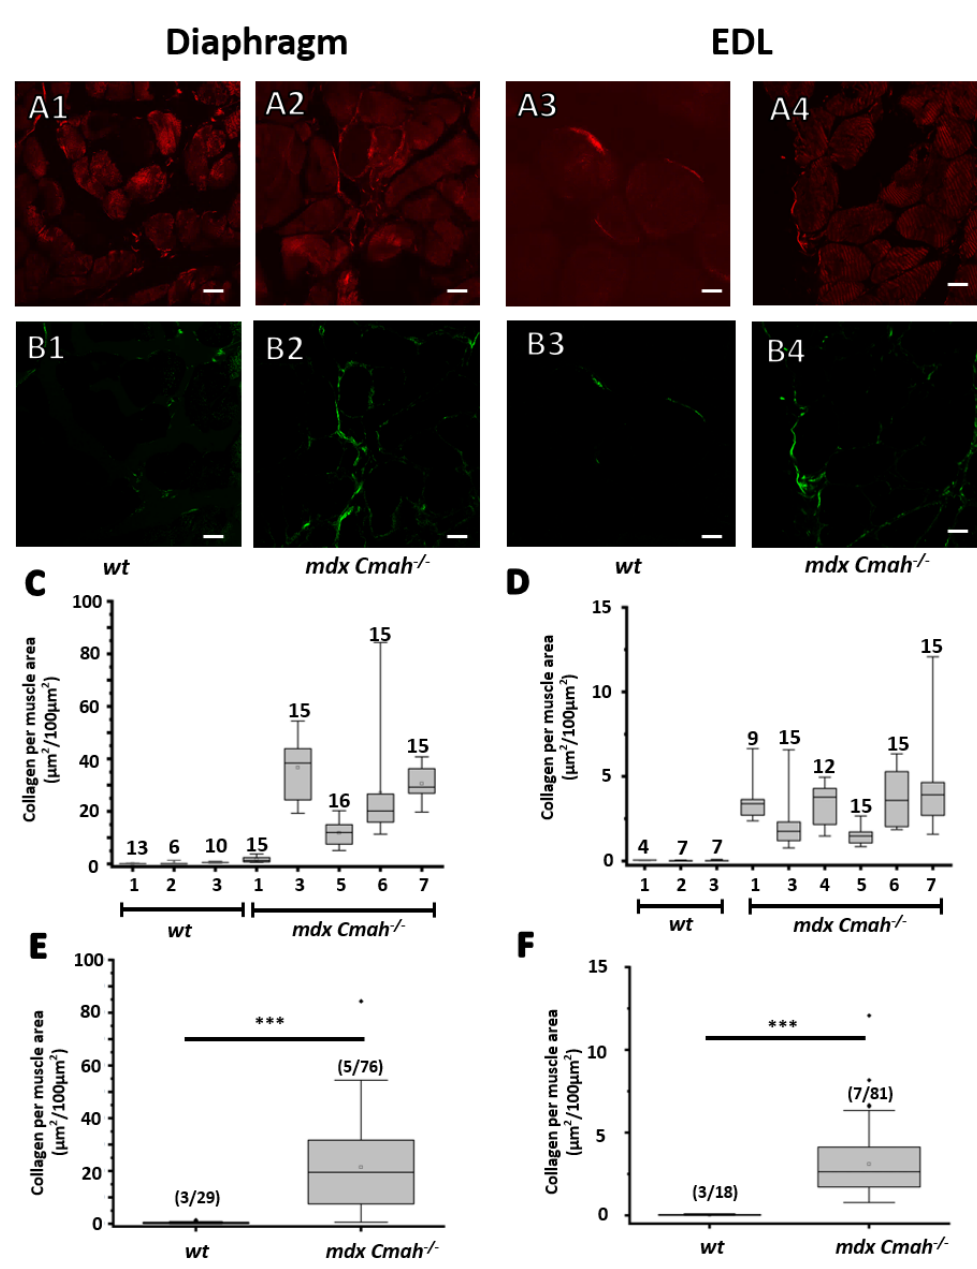
Figure 2. Marked fibrosis in mdx Cmah − / − diaphragm and EDL muscle sections assessed through label-free SHG morphometry. ( A – C ) Imaged and quantified collagen area per muscle tissue area. SHG signals are collected in forward scattered direction and collect both residuals of myosin-II and collagen ( A1 – A4 ). The myosin area was extracted via the measured autofluorescence in back- ward scattered direction and subtracted from the SHG signal resulting in quantifiable collagen areas ( B1 – B4 ). mdx Cmah − / − diaphragms tend to be highly fibrotic ( C ) more so than mdx Cmah − / − EDL ( D ). Combined results demonstrate a highly significant difference in collagen content per muscle area ( E , F ). Note the different ordinate scales in ( C , E ) and ( D , F ) (scale bar: 20 µ m, *** p < 0.001, (m/n)) relate to